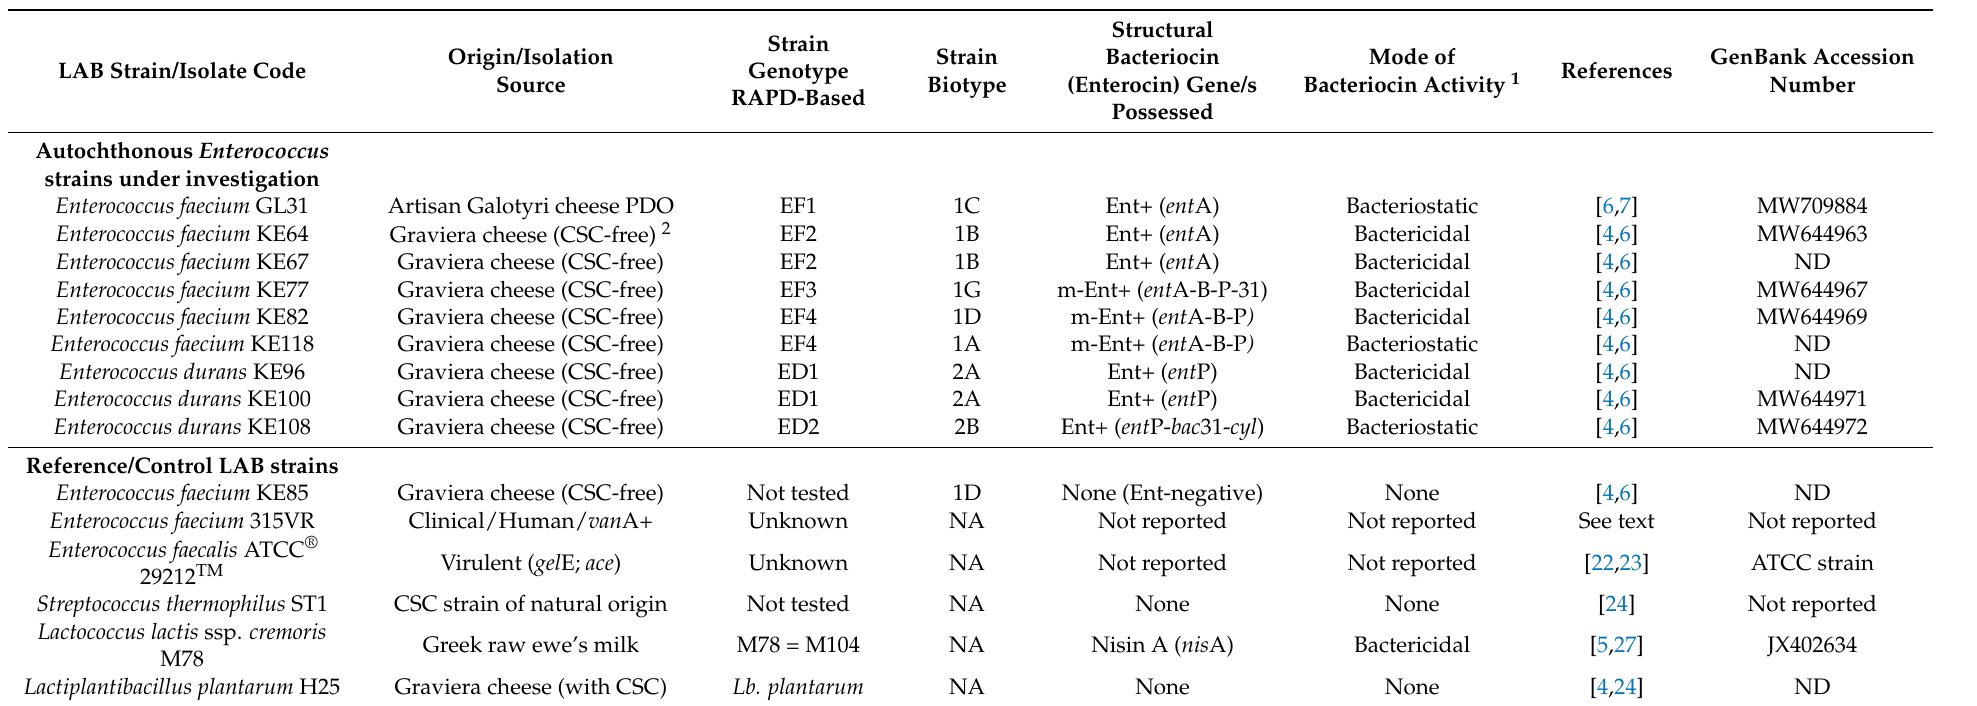
Table 1. Strains of lactic acid bacteria (LAB) used in this